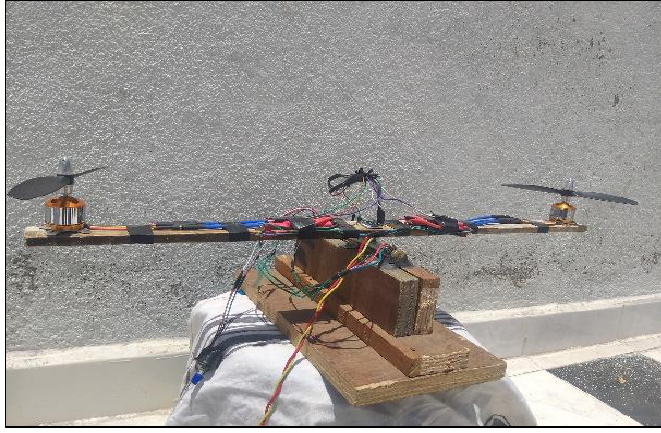
Figure 1: System model (Hardware).